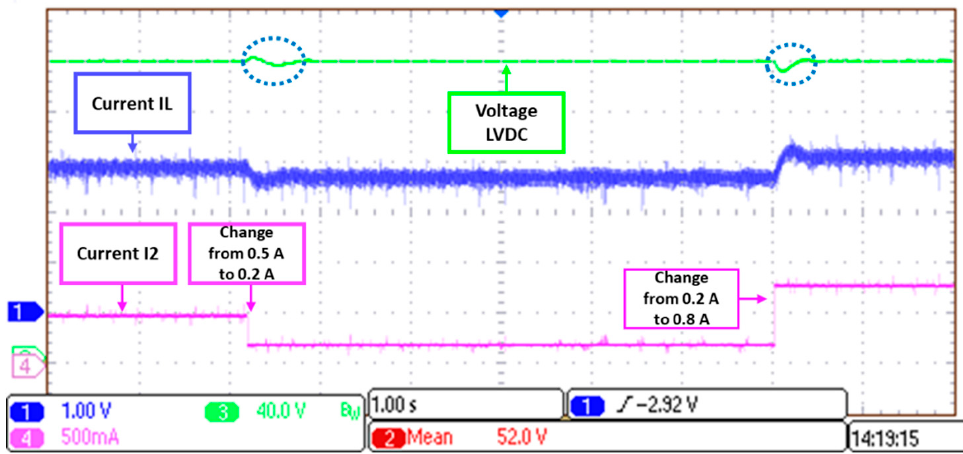
Figure 17. Experimental waveforms during validation of load disturbance regulation in boost mode.